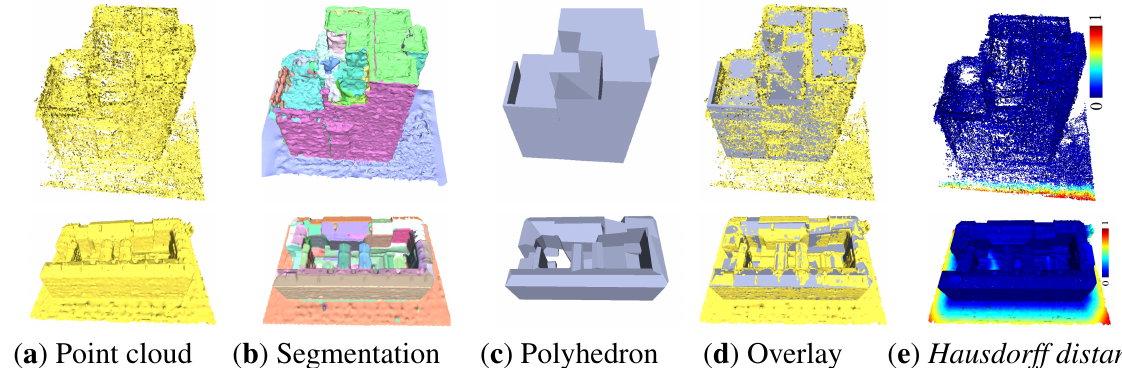
Figure 18. Comparison with SABMP [11] in terms of RMS values.